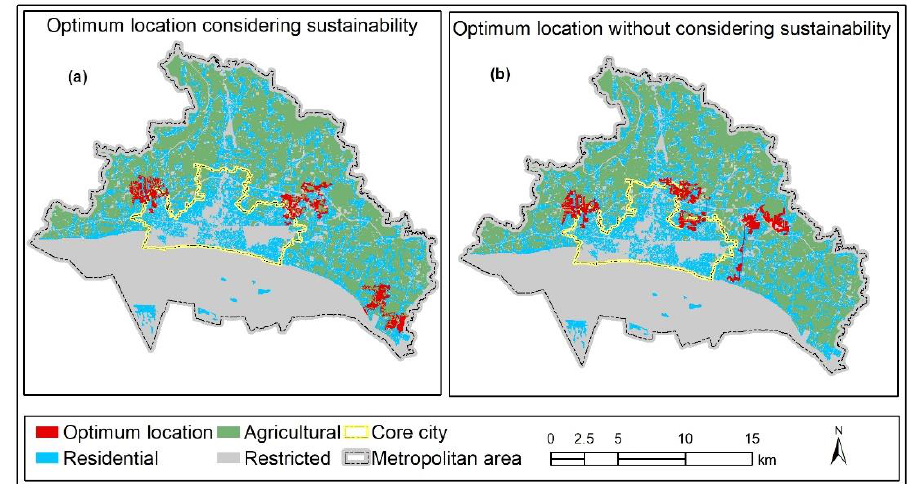
Figure 7. Optimal location of residential land: ( a ) considering sustainability and ( b ) without considering sustainability. Table 6. Sustainability benefit values of optimal land